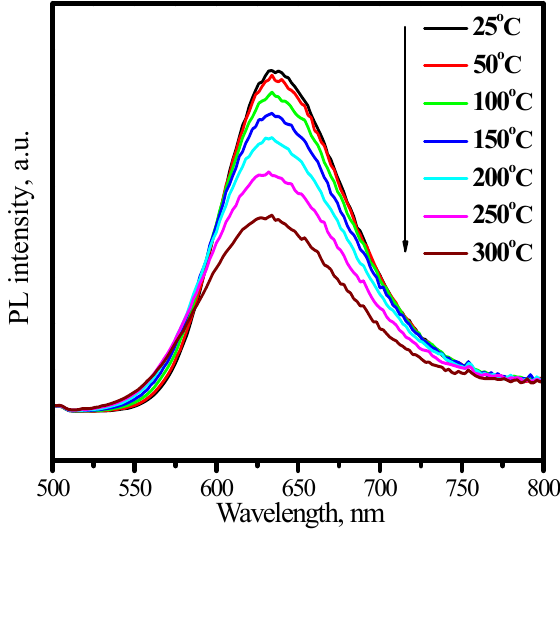
Figure 27. Emission ( λ nm excitation measured at different